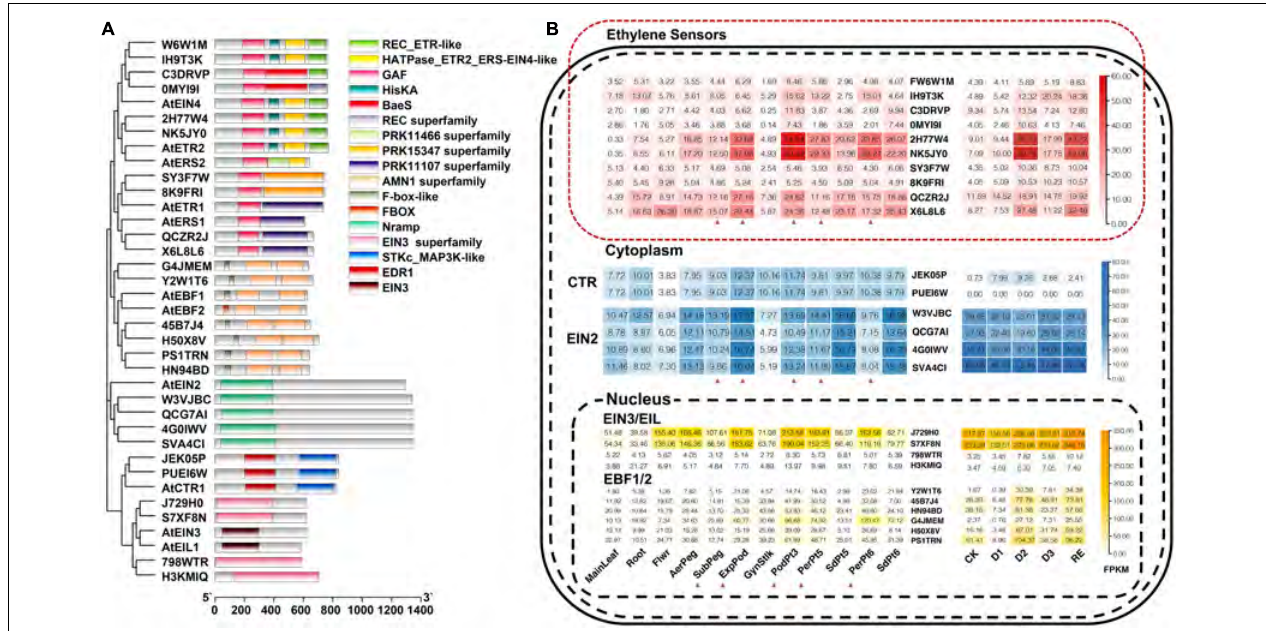
FIGURE 1 | Conserved domain and expression of ethylene sensors, constitutive triple responses ( CTR s), ethylene insensitive 2 ( EIN2 s), ethylene insensitive 3/ethylene insensitive 3-like ( EIN3/EIL s), and EIN3-binding F-box proteins ( EBF s). (A) Conserved domain of ethylene sensors, CTR s, EIN2 s, EIN3/EIL s, and EBF s in Arachis hypogaea ( A. hypogaea ) genome; (B) Developmental expression analysis of ethylene sensors, CTR s, EIN2 s, EIN3/EIL s, and EBF s in A. hypogaea genome. The red triangle indicates the tissues that experience mechanical stress.